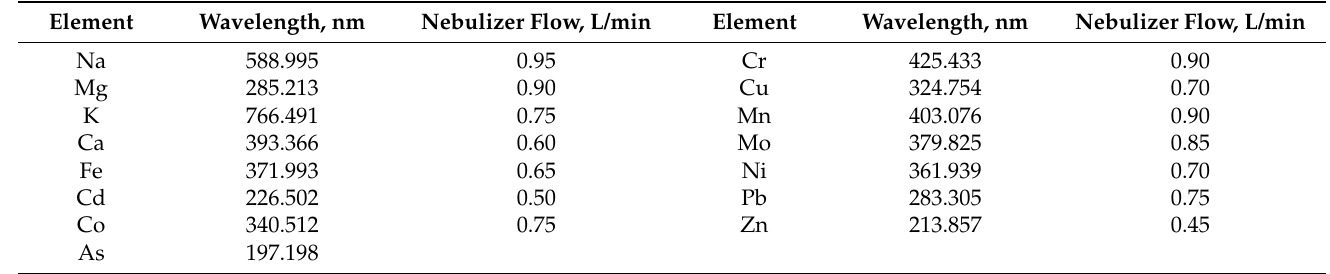
Table 8. Detection conditions for micro- and macro-elements by atomic emission